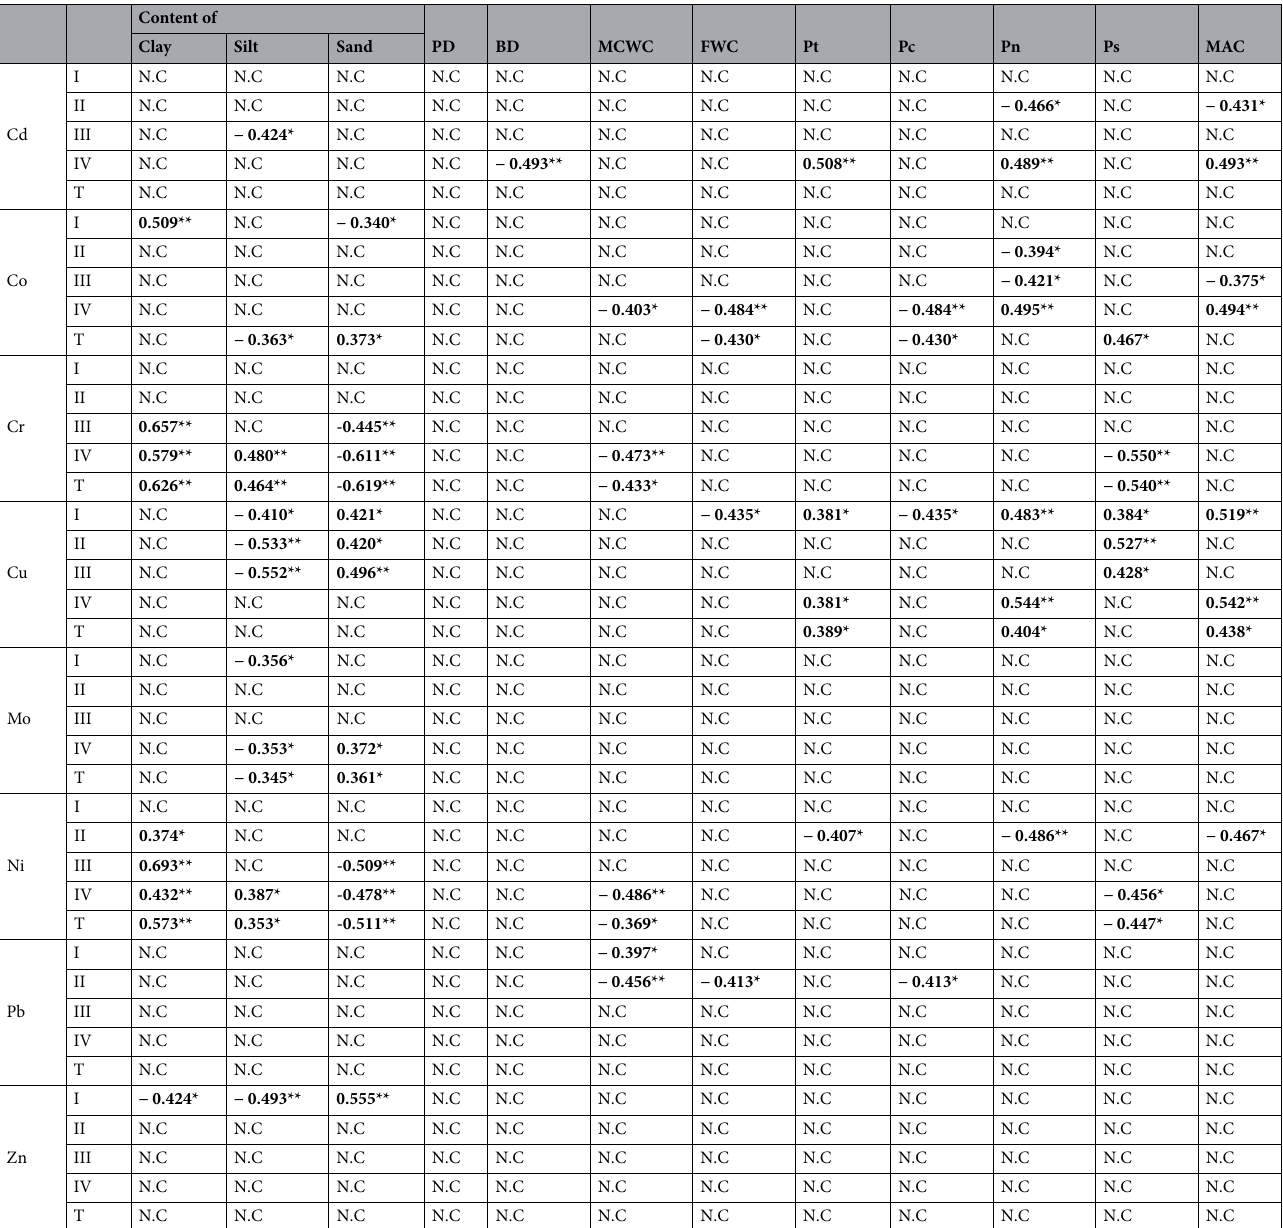
Table 6. Pearson´s correlation coefficient matrix of HMs in various fractions and soil physical properties. I exchangeable fraction, II reducible fraction, III oxidisable fraction, IV residual fraction, T total content, *r values shown in bold are significant at p < 0.05, **r values shown in bold are significant at p < 0.01, N.C no